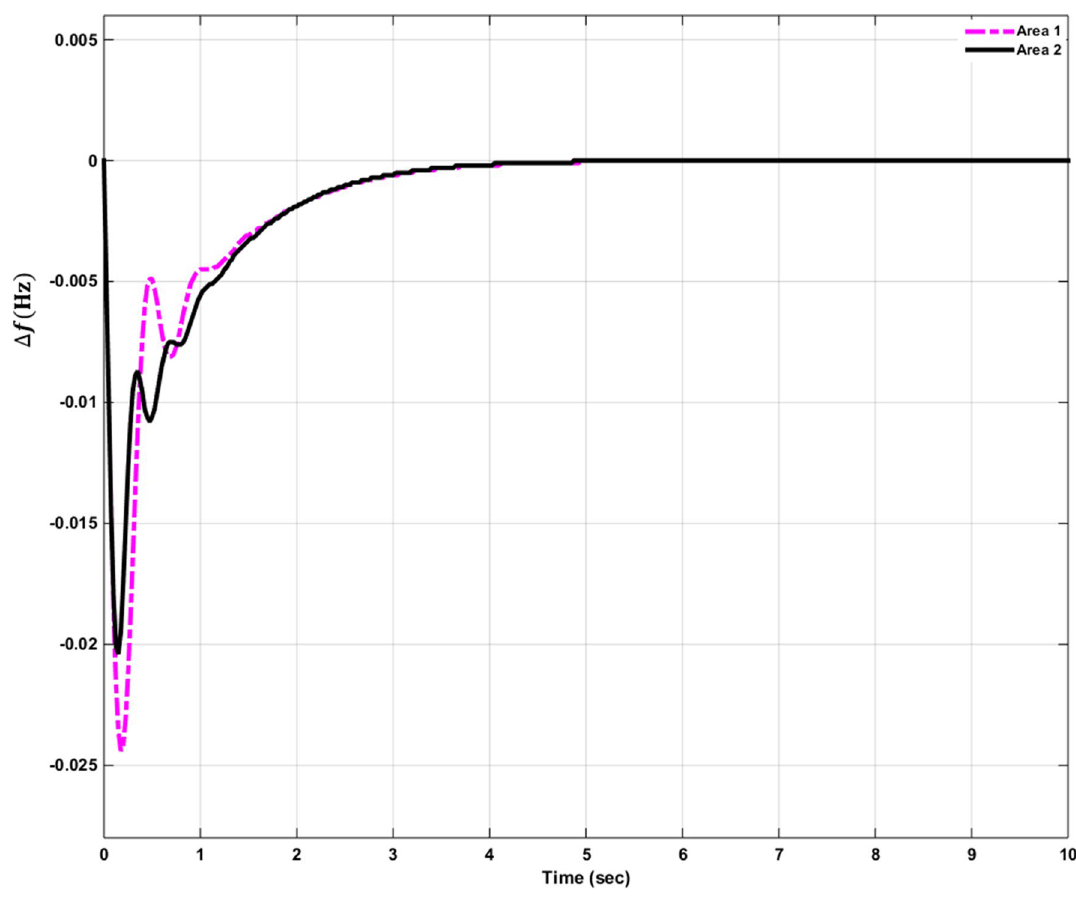
Figure 14. Frequency deviations for Areas 1 and